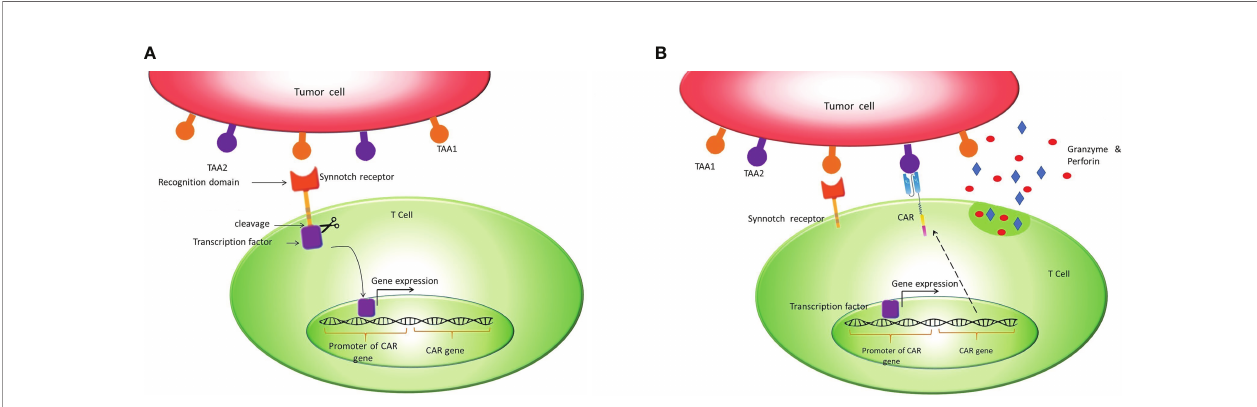
FIGURE 2 | Synnotch receptor CAR T cells: Synnotch receptors are designed to pursue the AND logic gate to mitigate on-target/off-tumor toxicity. (A) These receptors release a synthetic chimeric transcription factor (GAL4-VP64) after recognizing tumor-associated antigen 1 (TAA1). (B) The transcription factor binds to the GAL4 responsive promoter and induces the expression of CAR